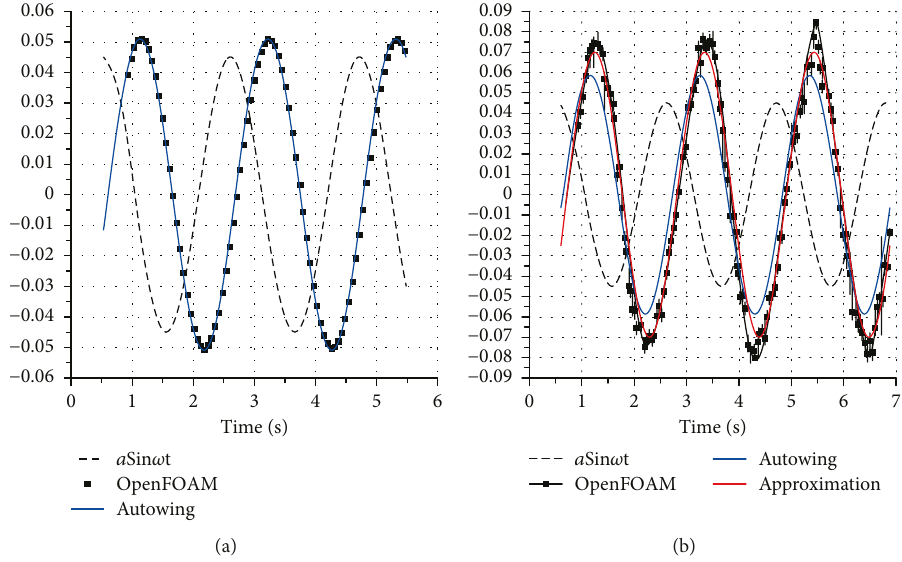
Figure 8: The unsteady time-dependent force part Δ C fl ight height a sin ω t ; solid line: VLM calculations using Autowing; fi lled squares: OpenFOAM CFD computations.